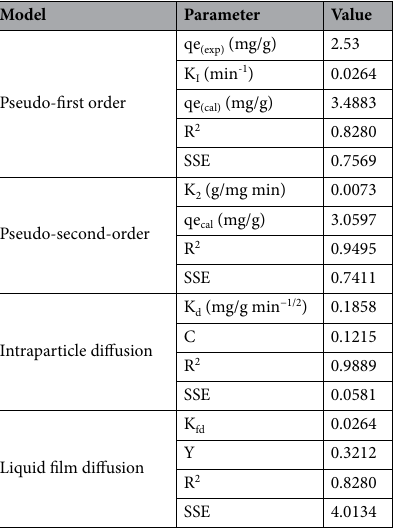
Table 3. The kinetic parameters for bromophenol blue adsorption onto ZnONPs.